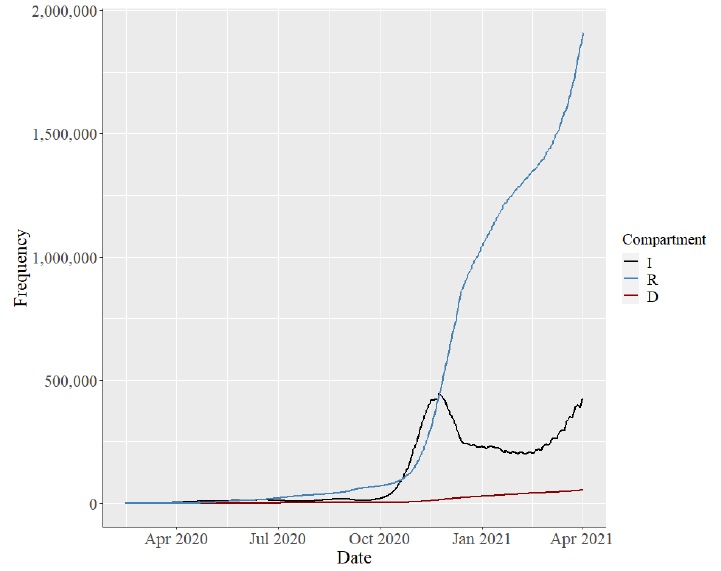
Figure 6. Discrete estimated SIRD plot for Poland COVID-19